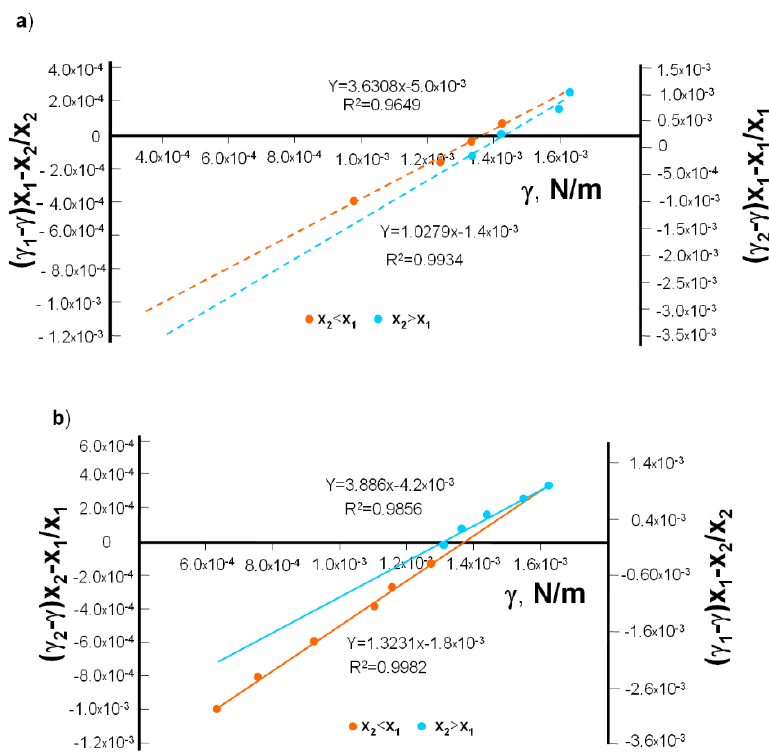
Figure 6. Graph showing Equations (9) and (10) for determining B 1 , B 2 , and γ : parameters: ( a ) the DPPC-diosgenin system and ( b ) the DPPC-diosgenin acetate system.